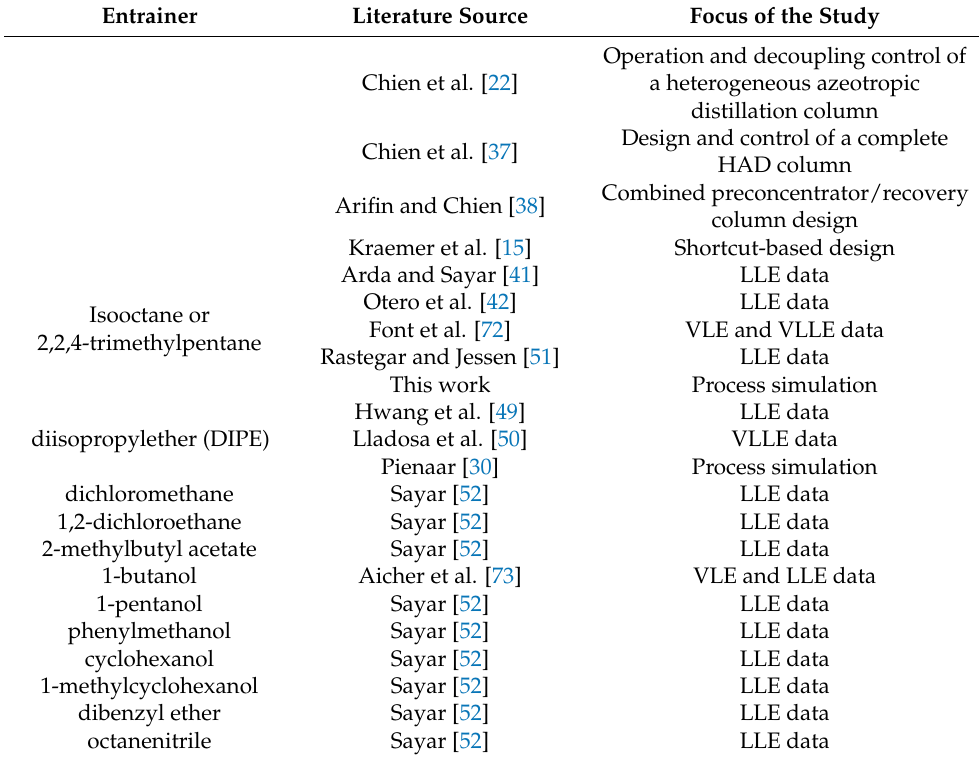
Table 2. Cont. Entrainer Literature Source Focus of the Study Operation and decoupling control of Chien et al. [22] a heterogeneous azeotropic distillation column Design and control of a complete Chien et al. [37] HAD column Combined preconcentrator/recovery Arifin and Chien [38] column